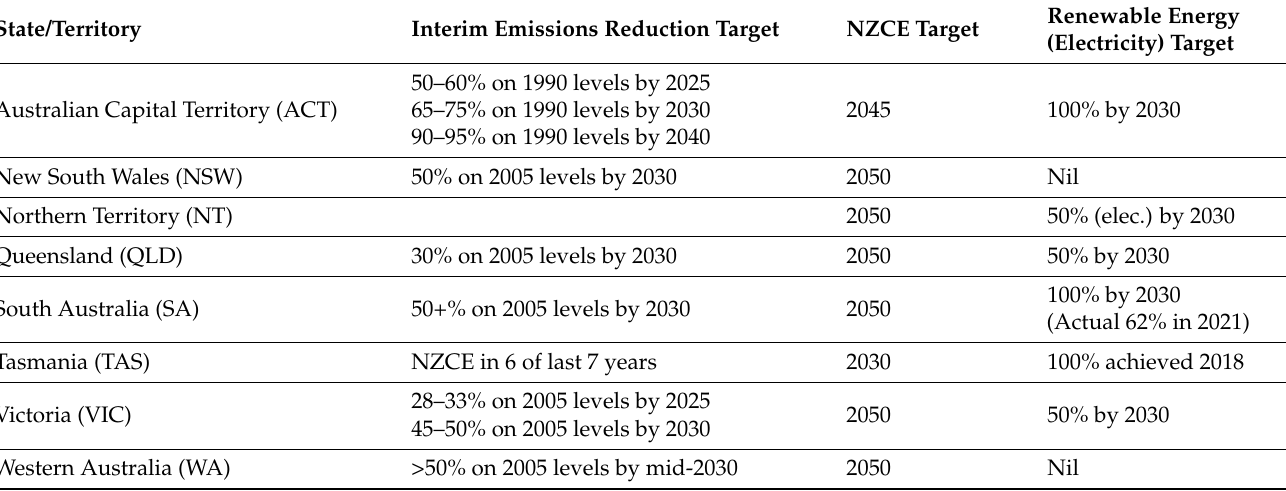
Table 3. NZCE and interim emissions reductions targets in Australian states and territories.